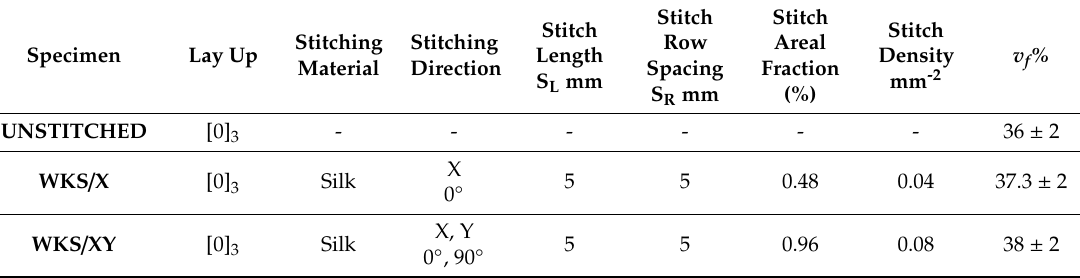
Table 1. Summary of the stitching parameters and